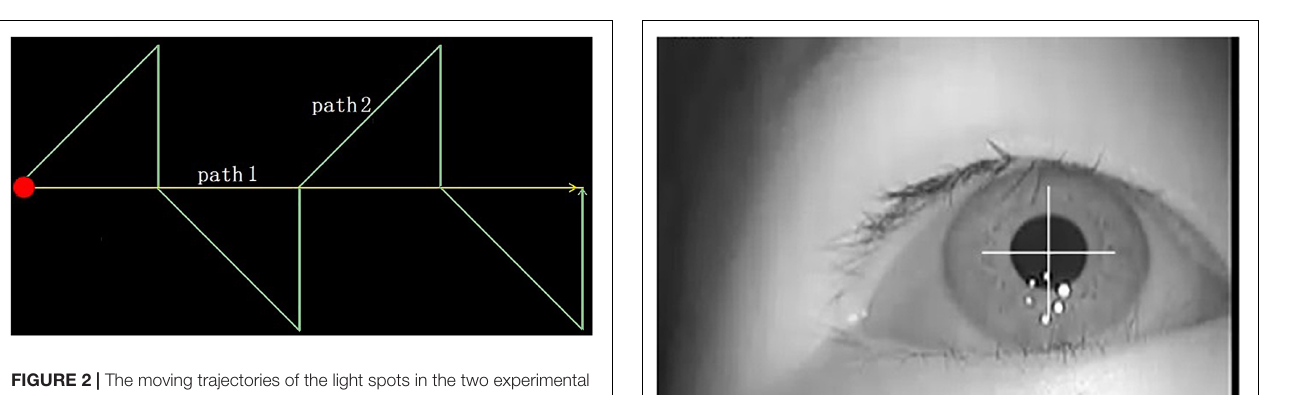
on the same computer as that generating the tracking image.